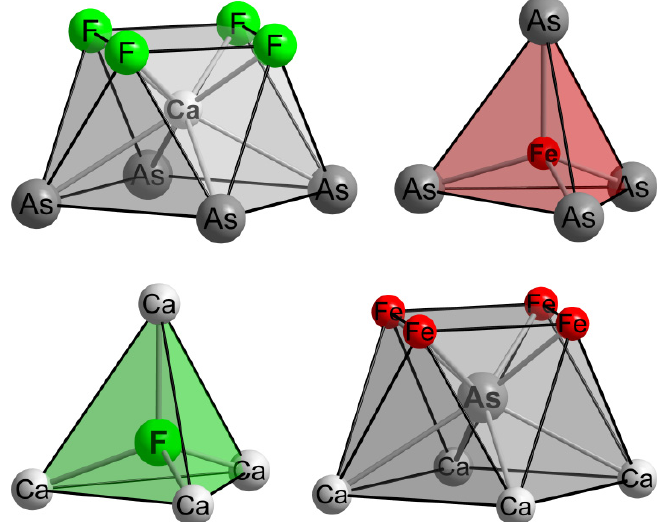
Figure 3. Coordination polyhedra around the four crystallographically independent atoms in Ca Na 1 − x x